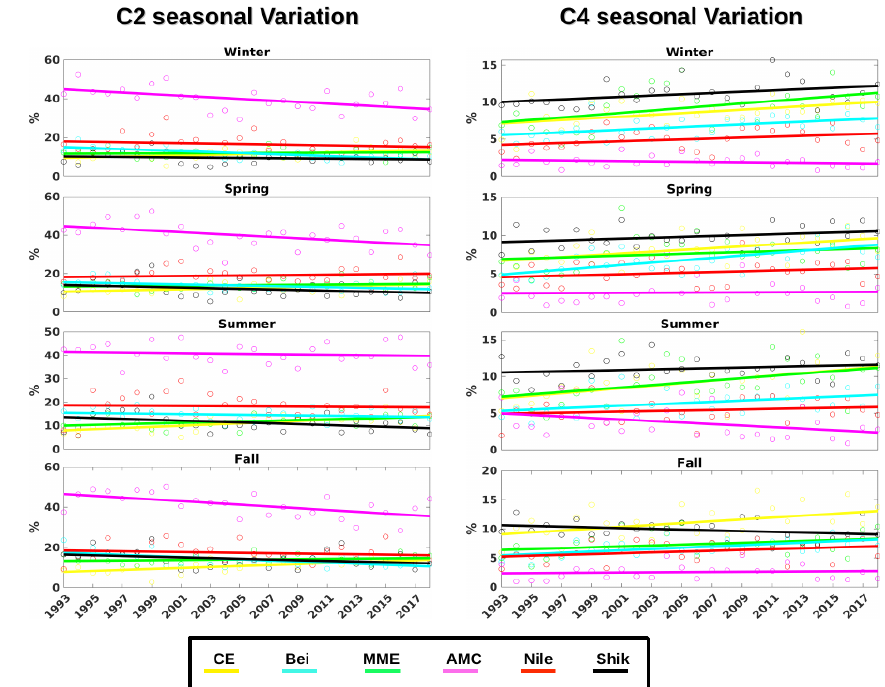
Figure A2. The seasonal variation of the C2 and C4 average in each box and their resulting linear